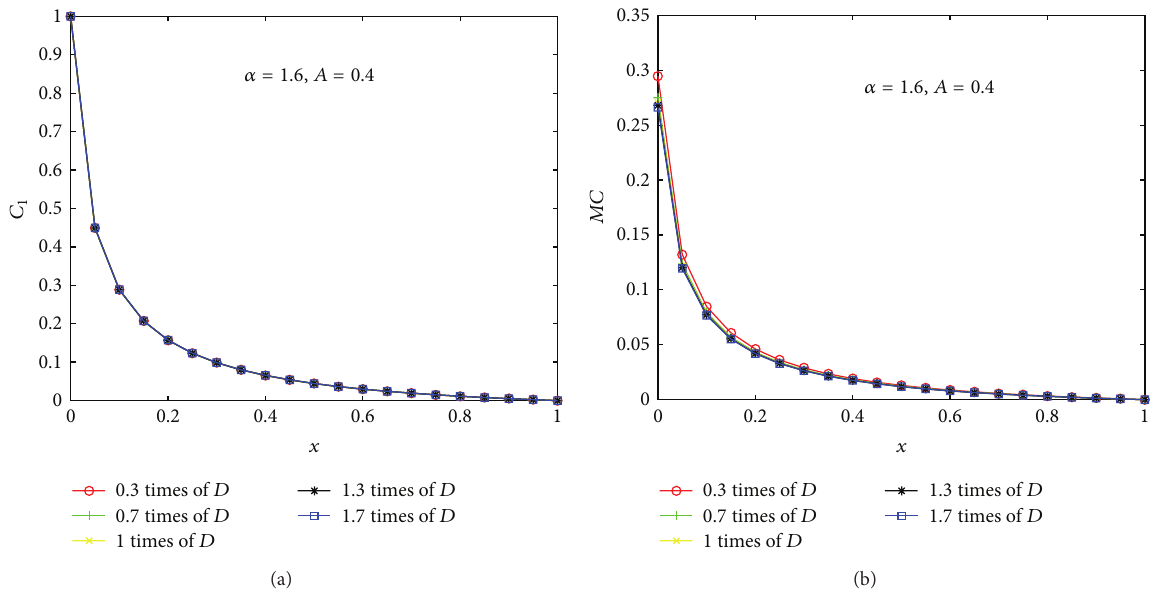
Figure 2: (a) is 𝐶 1 , plotted against 𝑥 for different values of 𝐷 𝛼 when 𝛼 = 1.6 ; (b) is 𝑀𝐶 , plotted against 𝑥 for different values of 𝐷 𝛼 when 𝛼 = 1.6